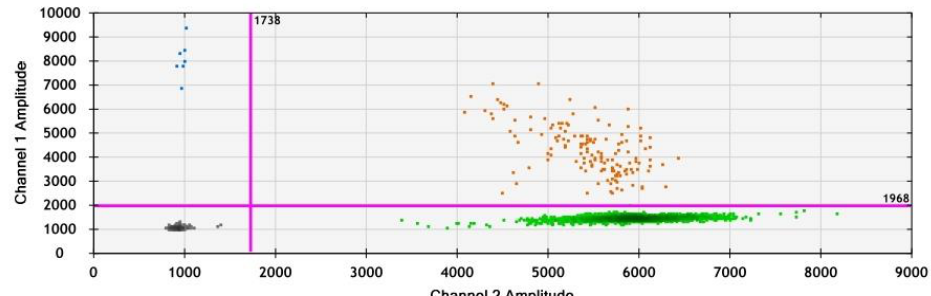
Figure 6. 2D-cluster plot of droplet fluorescence for both targets in a mutation detection absolute quantification assay. FAM-positive (channel 1, A143 allele) droplets form the top-left blue cluster, HEX-positive (channel 2, G143 allele) droplets form the bottom-right green cluster, negative droplets for both targets form the bottom-left grey cluster, and positive droplets for both targets form the orange cluster.